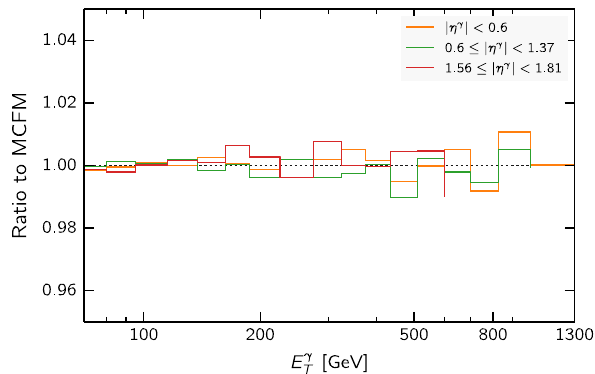
Fig. 4 The ratio of the APPLgrid computations of the NLO QCD cross-section to the corresponding MCFM v6.8 result for the kinematics of the first three rapidity bins of the ATLAS 8 TeV measurement, using in both cases the NNPDF3.1 set as